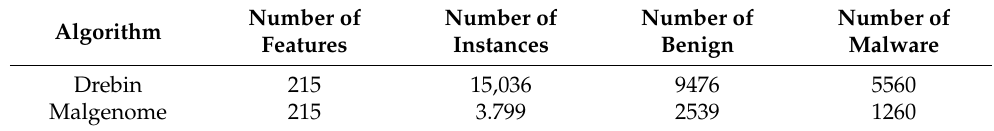
Table 4. Details of Android malware datasets.